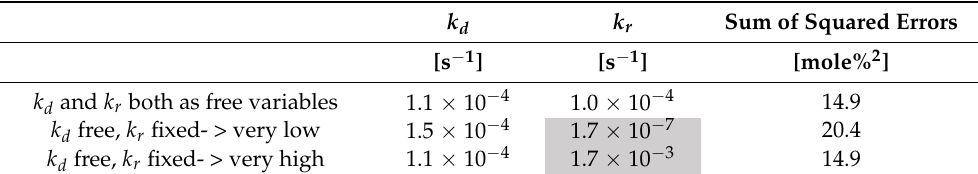
Table A1. Reaction rate constants k d and k r for depolymerization and repolymerization, determined by least squares regression of the data obtained from treating washed digestate. To estimate the influence of k r , fixed values (highlighted in gray), once for an extremely fast rate and once for an extremely slow rate, were specified for k r in order to find the limits for k d